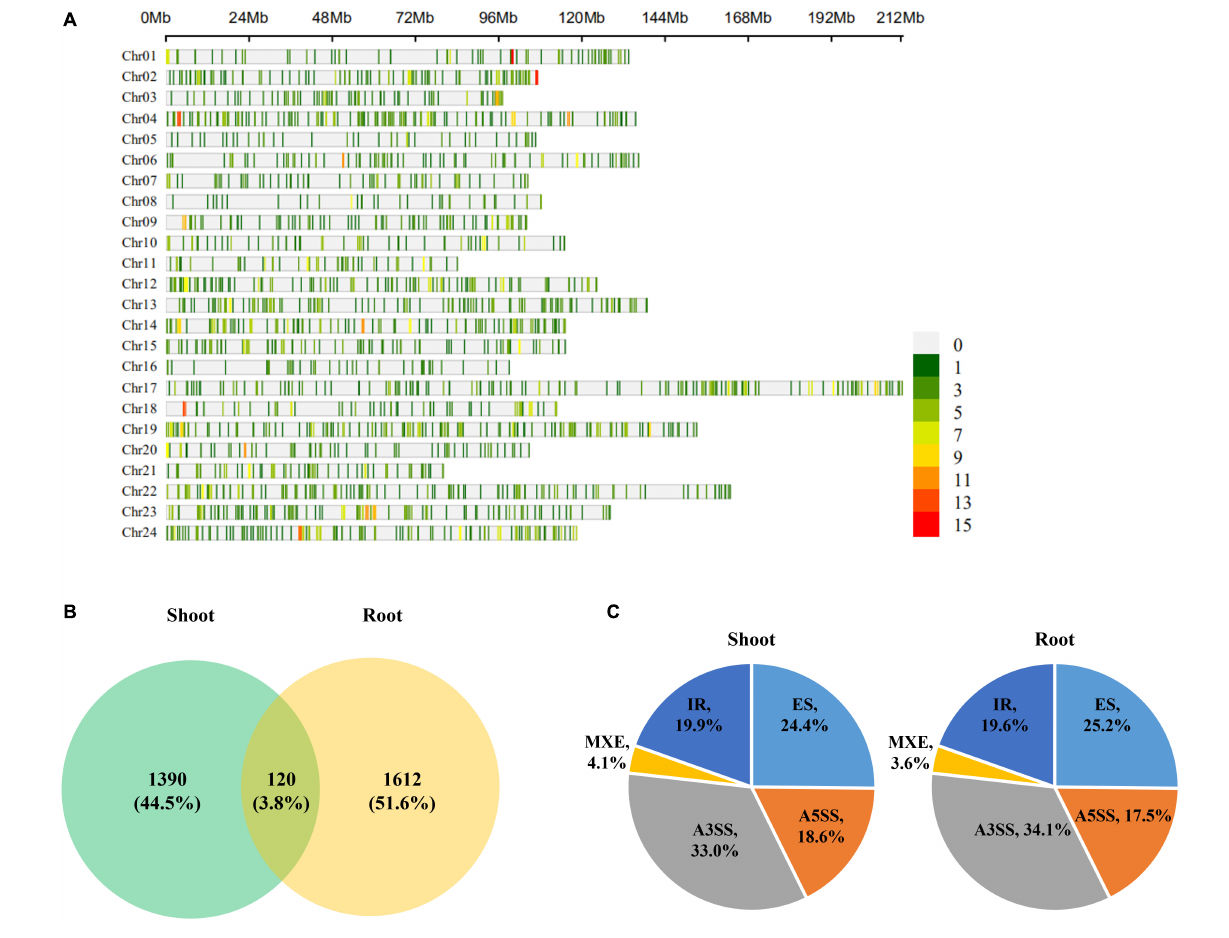
FIGURE 5 | Differentially alternatively spliced (DAS) events analyses of tobacco in response to low K + stress. (A) Chromosome distribution of DAS events in tobacco genome. The color bar on the right hand indicated the number of AS events within 1 Mb window size; (B) Venn diagram of DAS events in response to low K + stress in shoots and roots; (C) The distribution of different types of DAS events in shoots and roots. Chr: